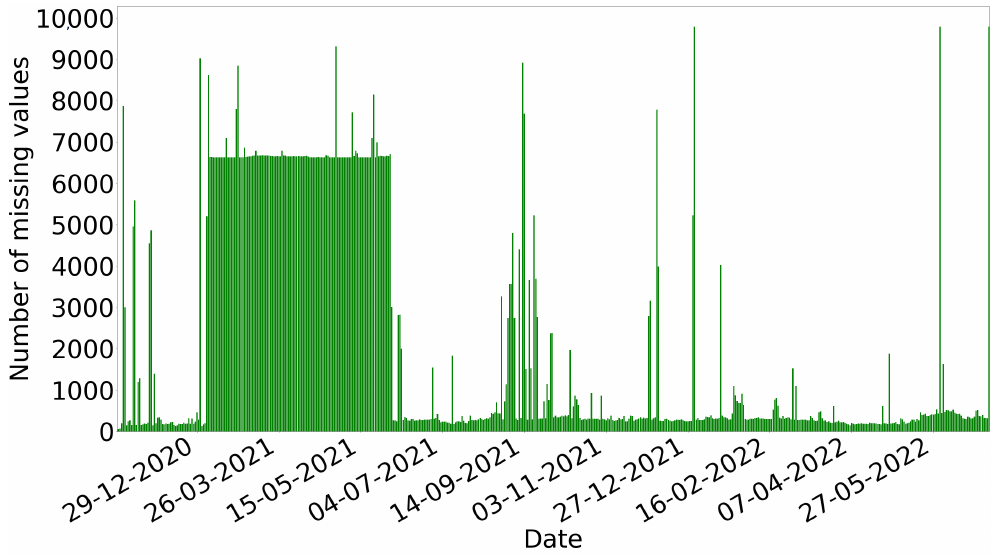
Figure 2. Number of observations that are missing per